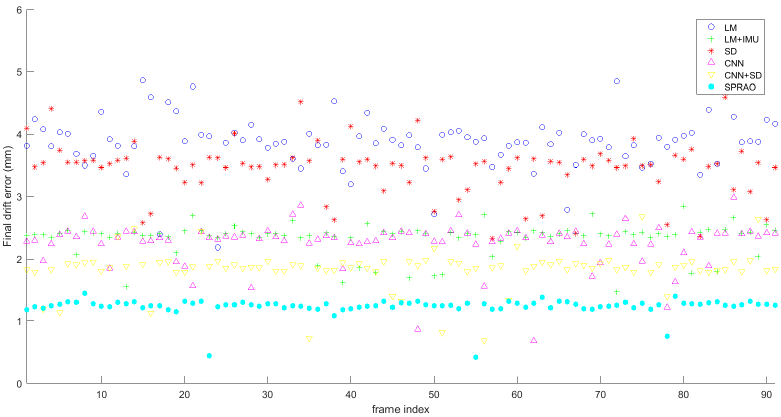
Figure 24. Reconstruction results of dataset DB1.